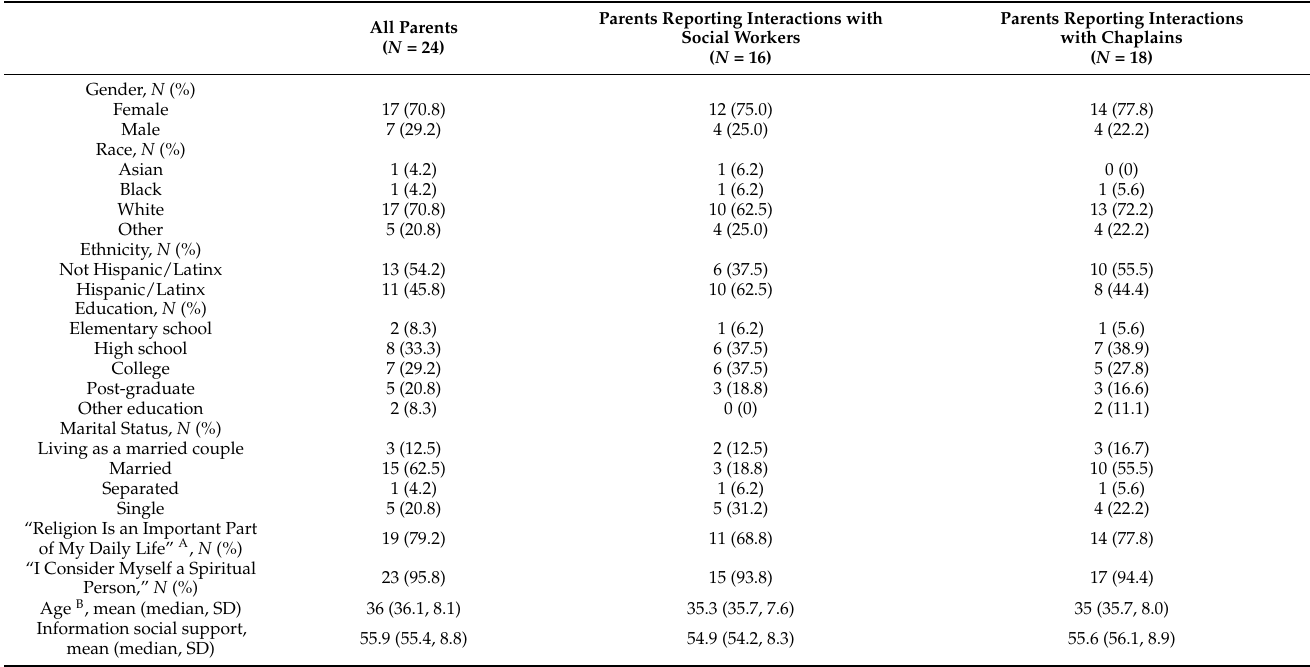
Table 1. Parent demographic characteristics.